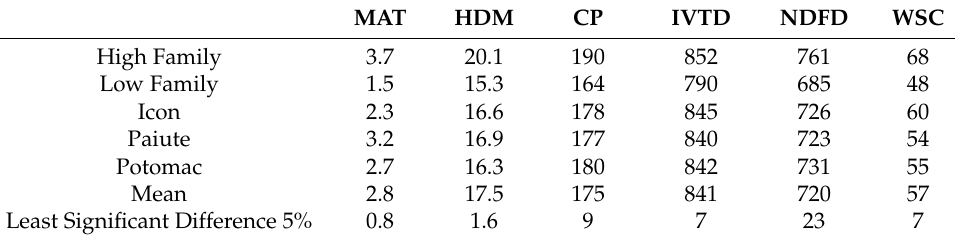
Table 3. Summary of the experiment-wide mean values corresponding to 58 orchardgrass families and three commercial cultivars evaluated in 2013 and 2014 at Lewiston and Millville, UT, under frequent and infrequent harvest frequencies. High and low family values correspond to the families with the numerically highest and lowest trait values. Means are across years, location, and harvest frequencies. Traits are maturity (MAT; 1—very late to 5—very early), herbage dry mass (HDM; Mg ha − 1 ), crude protein (CP; g kg − 1 ), in vitro true digestibility (IVTD; g kg − 1 ), neutral detergent fiber digestibility (NDFD; g kg − 1 ), and water soluble carbohydrate concentration (WSC; g kg − 1 ). MAT HDM CP